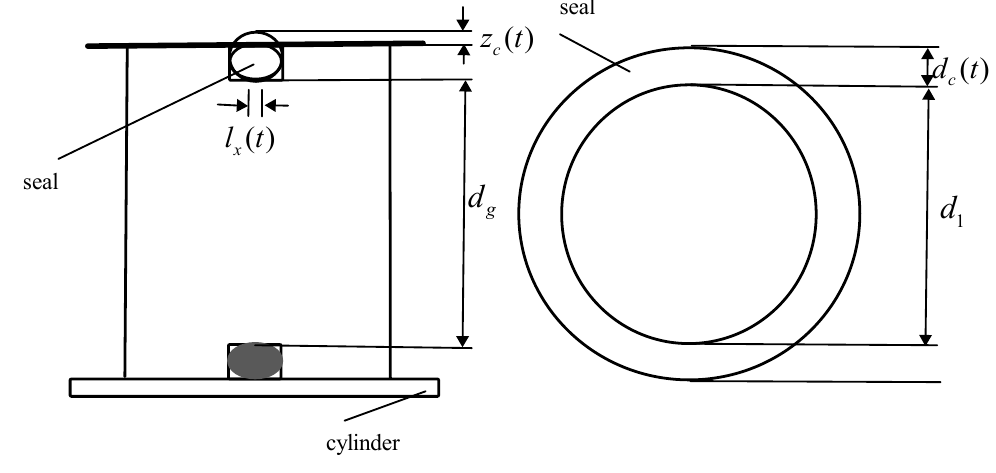
Figure A2. Schematic diagram of seal.